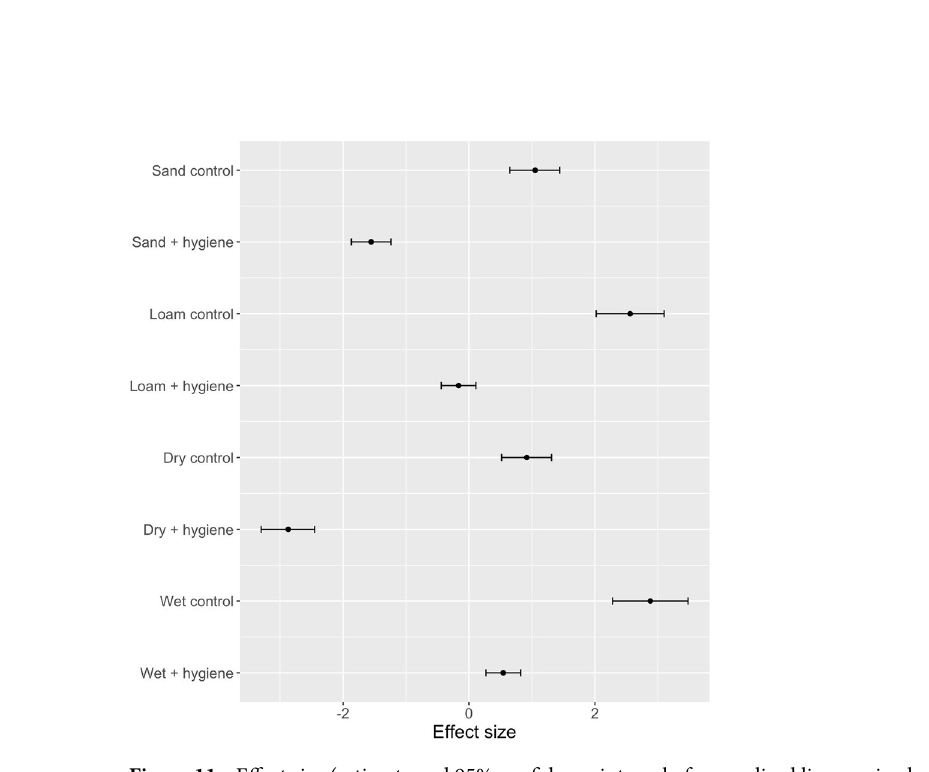
Figure 11. Effect size (estimate and 95% confidence interval of generalised linear mixed models) for soil type (sand or loam) and moisture (wet or dry), with or without hygiene; 95% confidence intervals that do not overlap can be considered significantly different. Positive effect values indicated that treated boots retained P. cinnamomi